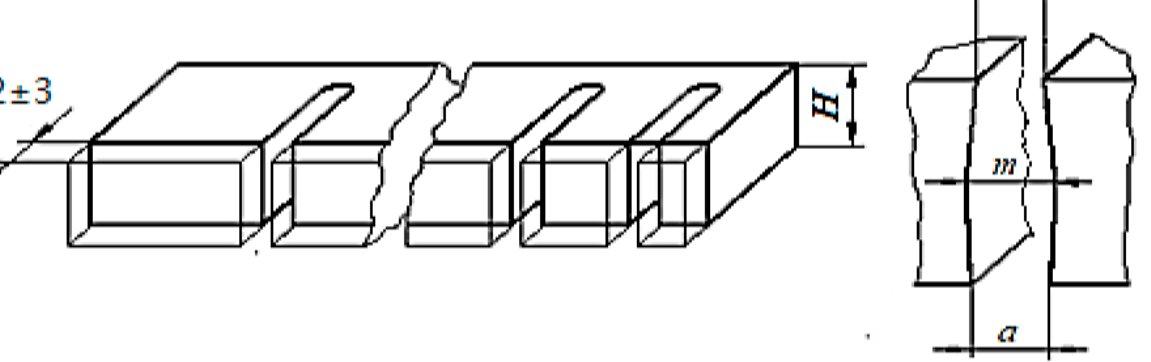
Figure 5. Making short slots in the test sample by wire electrical discharge machining in the experi- mental tests ( a ) and the main shape of the cross-section through the machined slot ( b